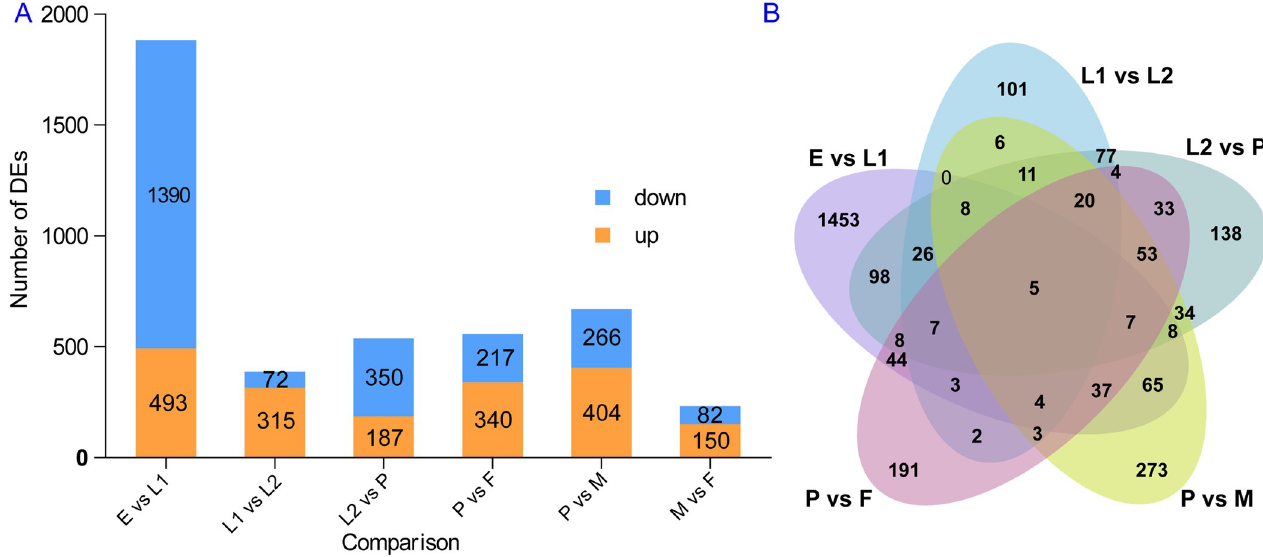
Fig 2. Expression profiles of Aedes albopictus putative lncRNAs. (A) Histogram showing DE lncRNAs among successive developmental time points; (B) Venn diagram displaying the number of overlapping DE lncRNAs between different groups. E, egg; L1, early larvae; L2, late larvae; P, pupae; F, female; M, male. https://doi.org/10.1371/journal.pntd.0010245.g002 highest correlation coefficient were selected for further research, including blue, pink, magenta, salmon, brown, and green module, which correlated to eggs (E), early larvae (L1), late larvae (L2), pupae (P), females (F), and males (M), respectively.